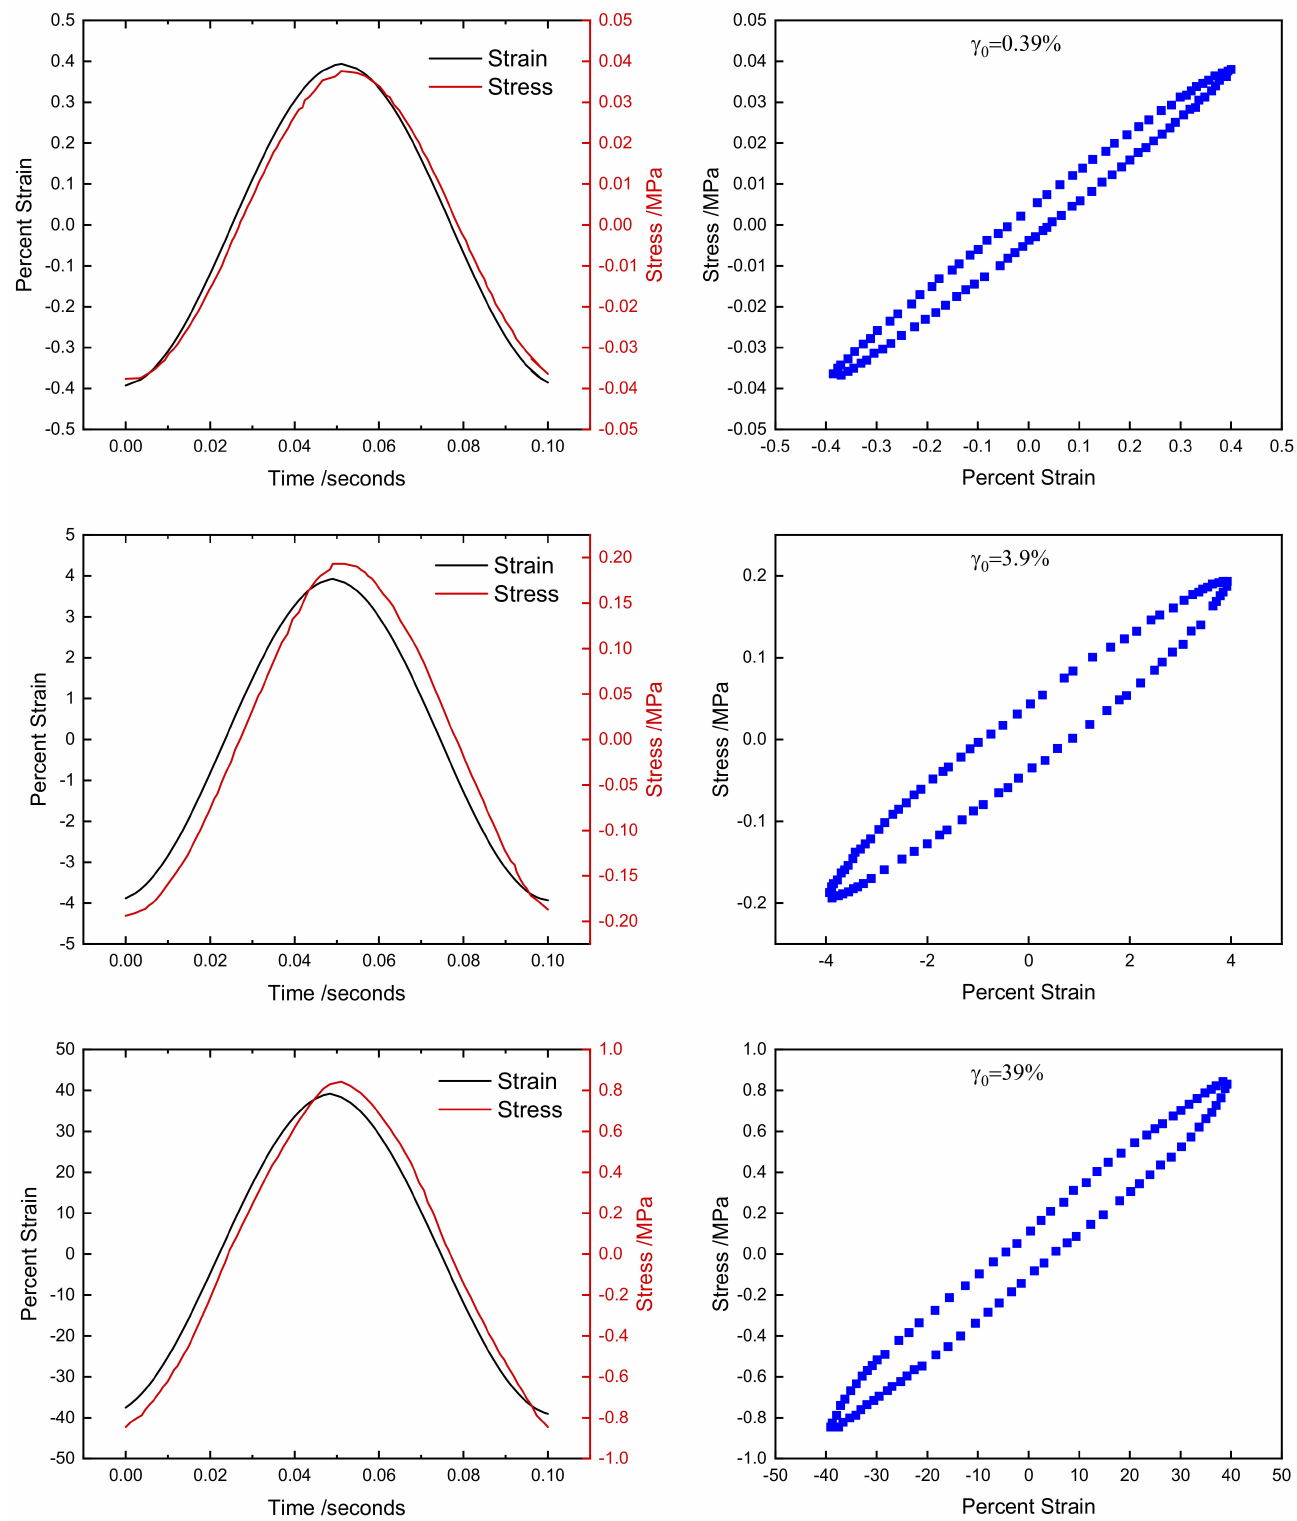
Figure 5. Stress–strain–time data for compound CB 107